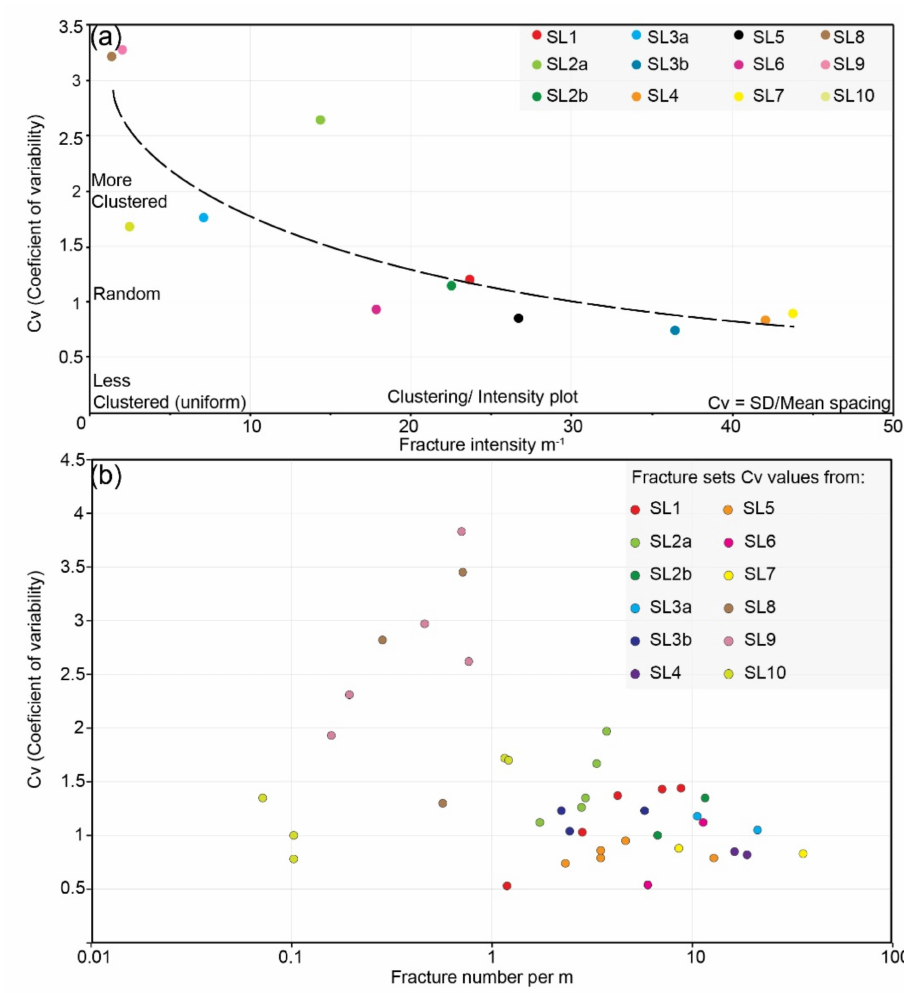
Figure 14. ( a ) Coefficient of variability (Cv) plotted against fracture intensity (P 10 ) of the NH studied outcrops. SD: Standard of deviation of spacing measured from each scanline; mean: Mean spacing measured from each scanline. ( b ) Coefficient of variability (Cv) plotted against fracture number normalized by the scanline